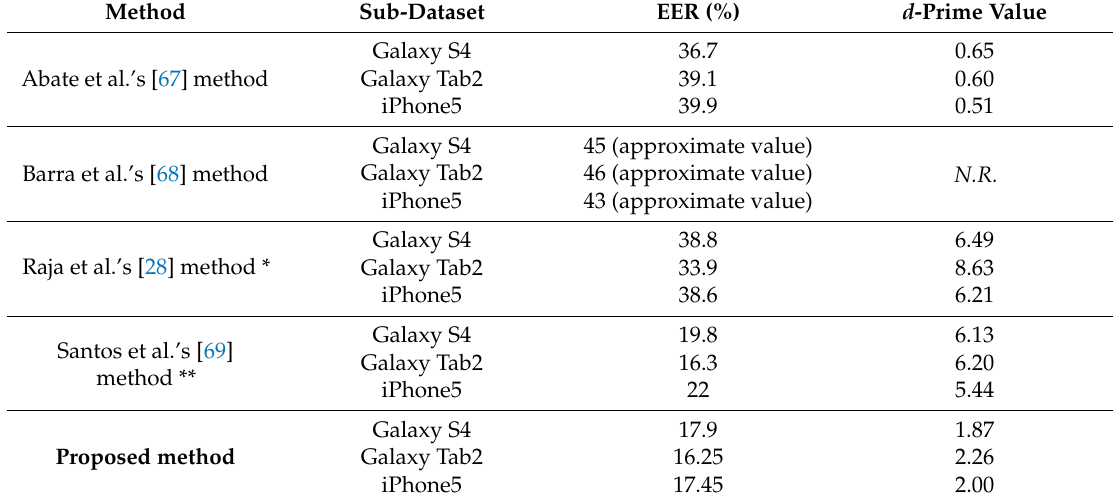
Table 8. Comparison between the recognition method suggested by this study and the methods of other preceding studies with the MICHE database including the data from indoors and outdoors ( N.R. means “not